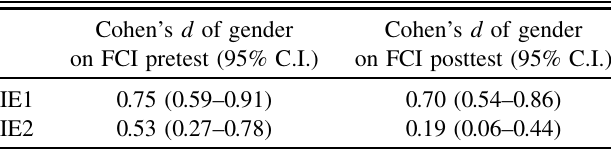
TABLE II. Effect sizes and confidence intervals (C.I.) compar- ing gender for students in IE1 and IE2, using the FCI pretest and FCI posttest from Lorenzo et al. Cohen’s d of gender on FCI pretest (95%